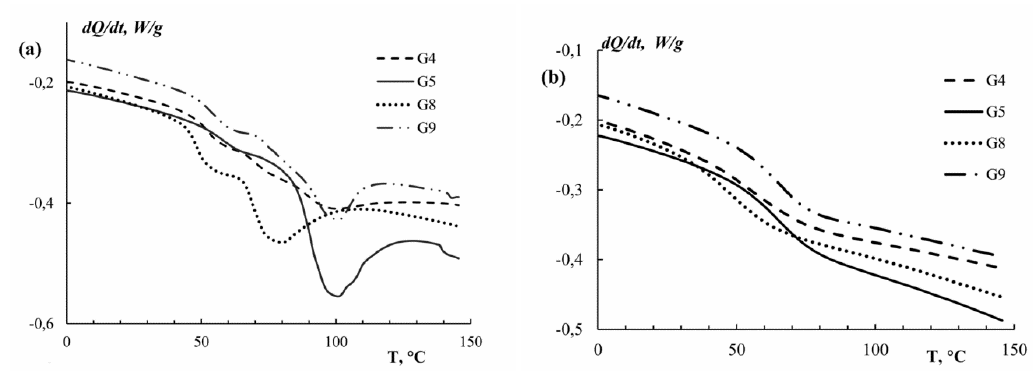
Figure 9. Thermograms of gelatin samples obtained at di ff erent pH ( a ) First heating cycle—determination of melting temperature and enthalpy; ( b ) second heating cycle—determination of glass transition temperature; the heating rate of 10 ◦ C / min.